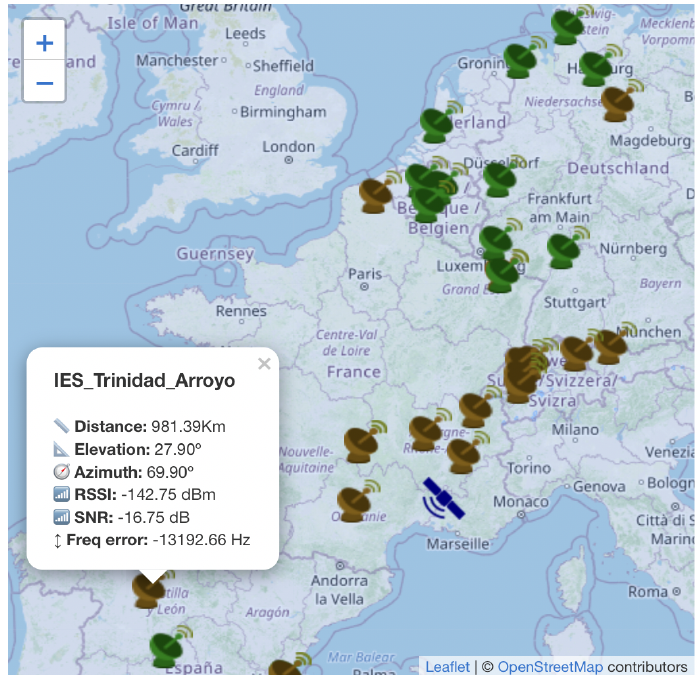
Figure 11. Early experiments with the recently launched SATLLA-2B pico-satellite. Using the TinyGS project, ground stations can receive and share RF data transmitted by LoRa based satellites. In this image, about 30 ground stations are receiving an RF beacon transmitted by SATLLA-2B (in a distance range of 550–2100 km). The ground stations marked in green received the beacon properly, while the brown one received CRC error; SATLLA-2B is marked in